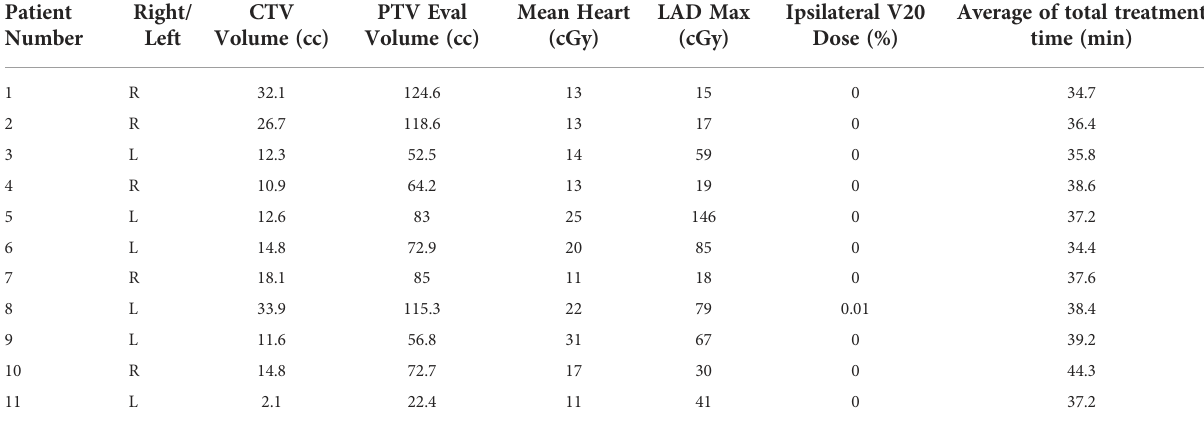
TABLE 2 Pertinent dosimetry characteristics of the eleven patient treatment